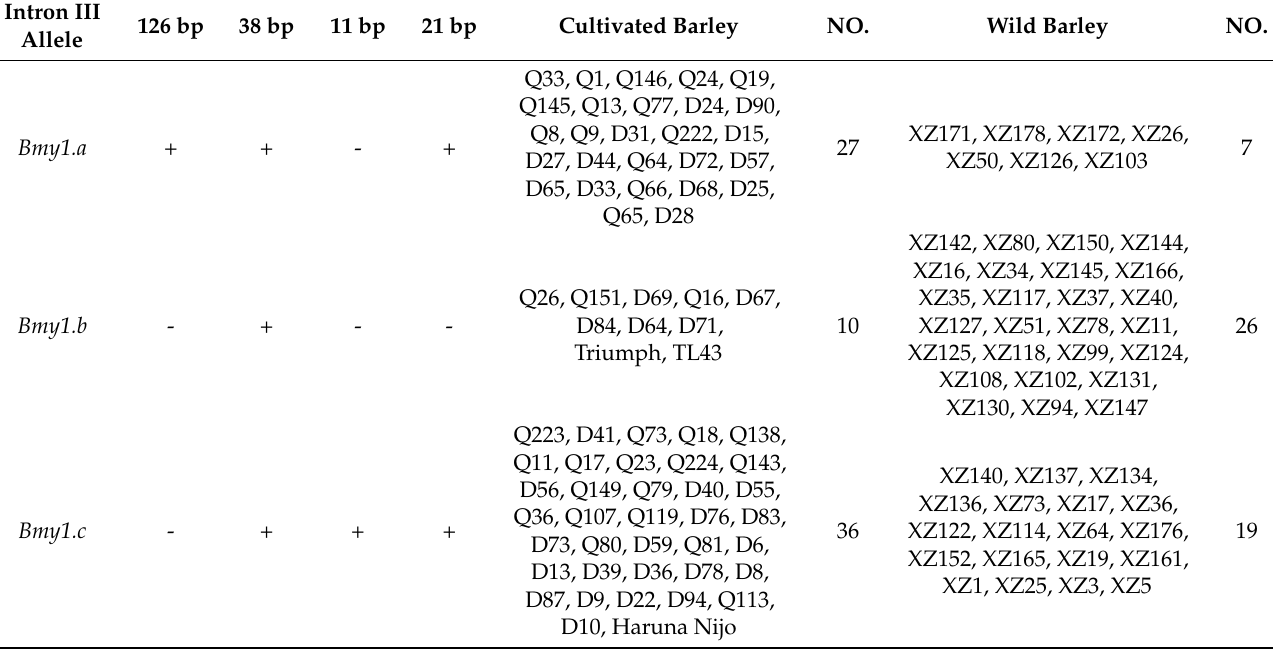
Table 2. Bmy1 intron III polymorphisms for 125 barley genotypes. Haruna Nijo was used as the reference. Cultivated Barley NO. Wild Barley NO.